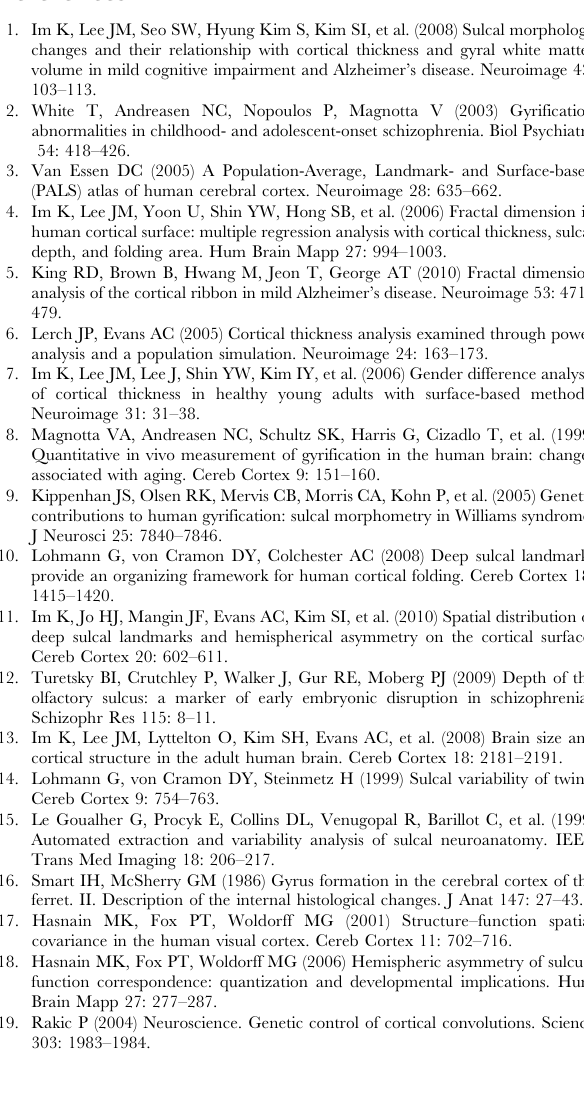
Figure S1 Computation time with division level in five individual subjects. X-axis indicates division level and y-axis means computation time for ADT. (TIF) Figure S2 Mean sulcal depth changed by division level in five individual subjects. (TIF) Table S1 Closed volume( mm 3 ) changed by kernel size in three AD subjects.